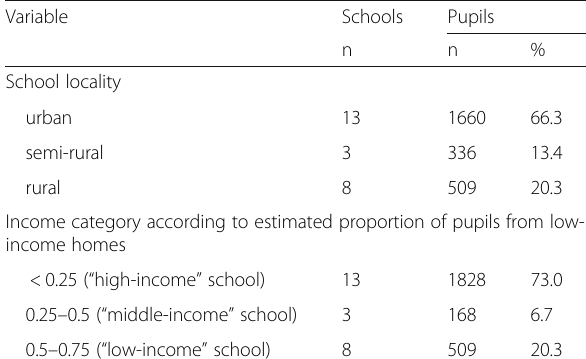
Table 1 School variables (from teachers ’ questionnaires), and numbers of participant pupils affected ( N = 2505)